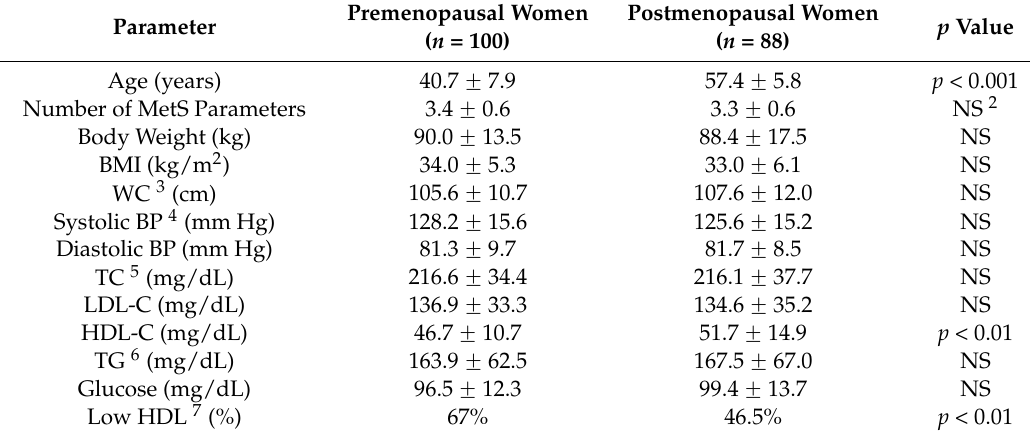
Table 1. Anthropometrics, blood pressure plasma lipids and plasma glucose of premenopausal and postmenopausal women with metabolic syndrome 1